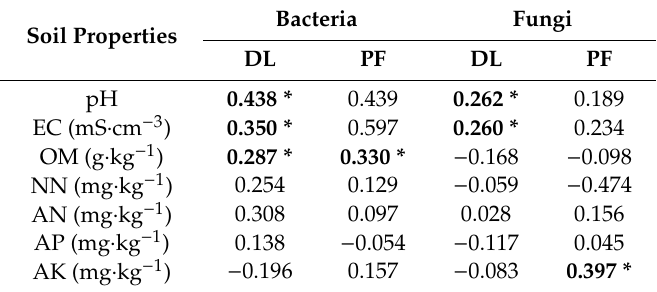
Table 2. Mantel Test between soil microbial community at the OTU level and environmental factors in DL and